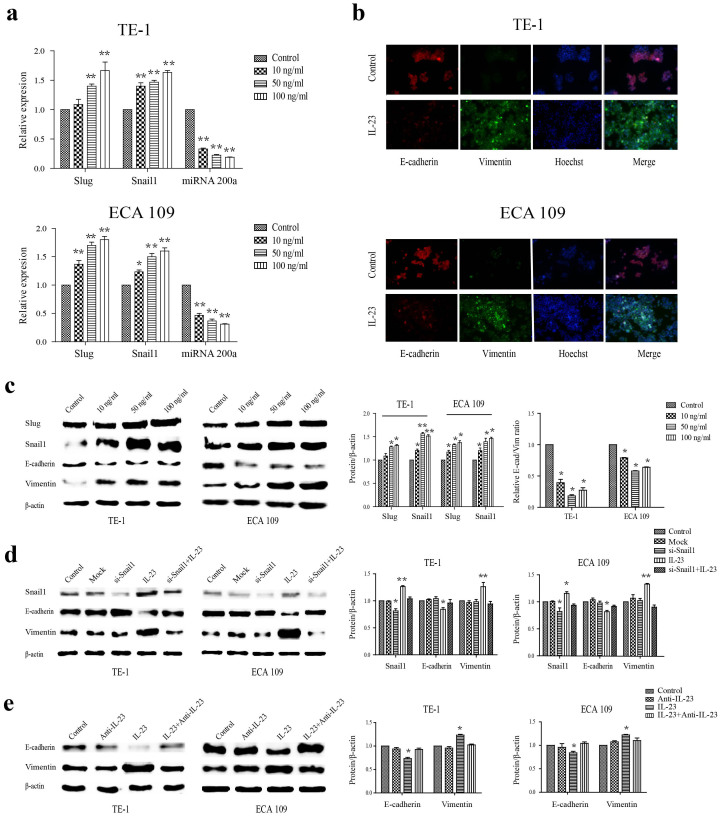
Expression of the EMT in OC cells cultured with IL-23.(a) Relative expression levels of slug, snail1 and miRNA 200a after the treatment with different concentrations of IL-23 (0, 10, 50, 100 ng/ml) by RT-PCR. The analysis of the CT values of oesophageal cancer cells was normalised to GAPDH for each sample. The normalised values (ΔCT) of all samples were compared with the control in each group (ΔΔCT). The results are expressed as 2-ΔΔCT, and the resulting data derive from at least three independent experiments. (b) Immunofluorescence: Cells were treated with 50 ng/ml IL-23 for 24 h and then stained for E-cadherin and vimentin. E-cadherin: red, vimentin: green, cell nuclei: blue. (c) Western blotting for slug, snail1, E-cadherin and vimentin: After the treatment with various concentrations of IL-23 (0, 10, 50, 100 ng/ml) for 24 h, the cells were lysed for western blot analysis. Quantification of the western blot results showing the changes in snail1 and slug expression and the E-cadherin/vimentin ratio. E-cad/Vim: E-cadherin/Vimentin. (d) and (e) The changes in E-cadherin and vimentin expression after pretreatment with siRNA targeting snail1 or in the level of IL-23 (50 ng/ml) after treatment with anti-IL-23 (1 μg/ml) by western blotting. Quantitative analysis of panels is showed in the bar chart. All data derive from at least three independent experiments. Mock: transfection with lipofectamine 2000 without siRNA, si-Snail1: siRNA snail1. *p < 0.05, **p < 0.01.